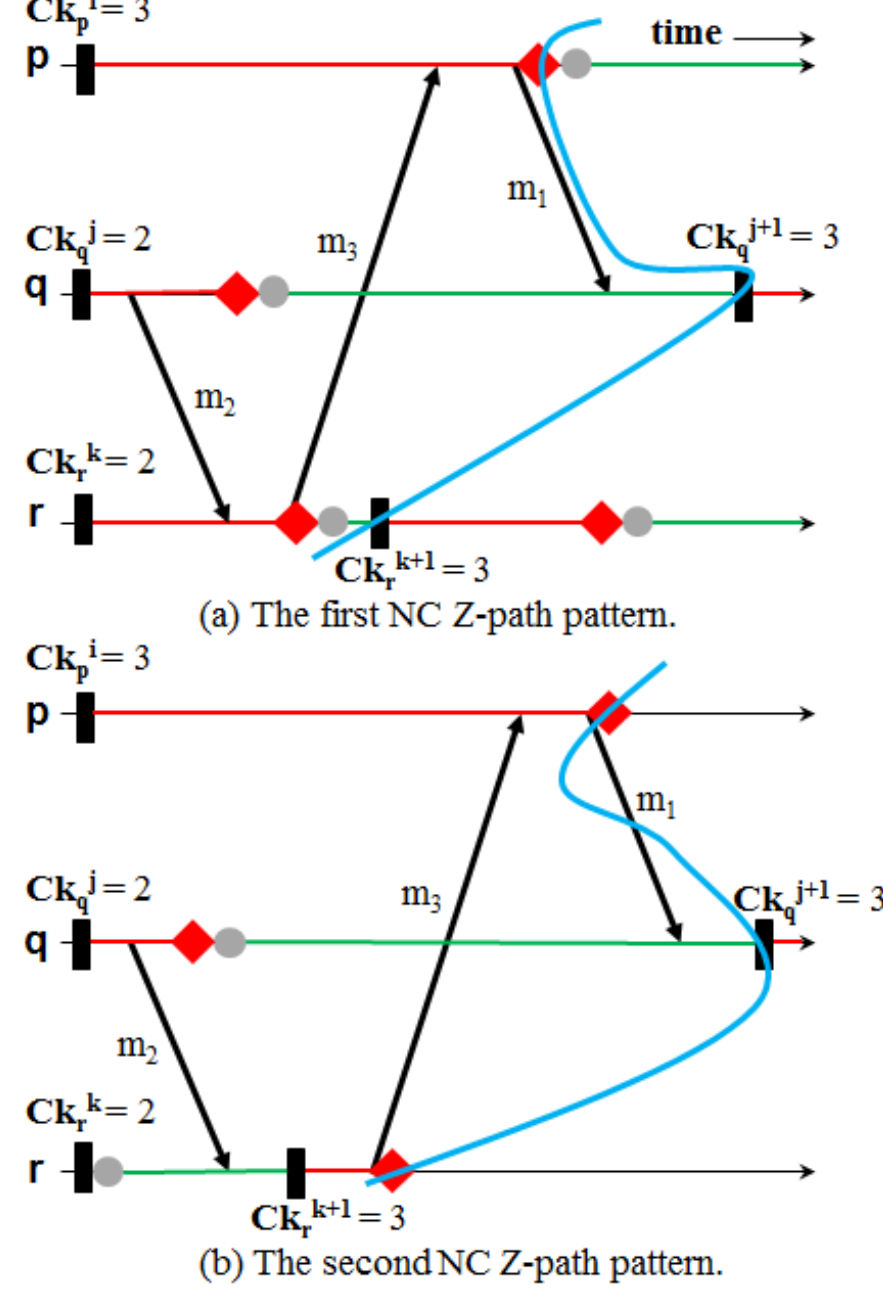
Figure 3. How S-CIC avoids forced checkpointing, unlike HMNR. Figure 4 presents the concrete algorithmic description of